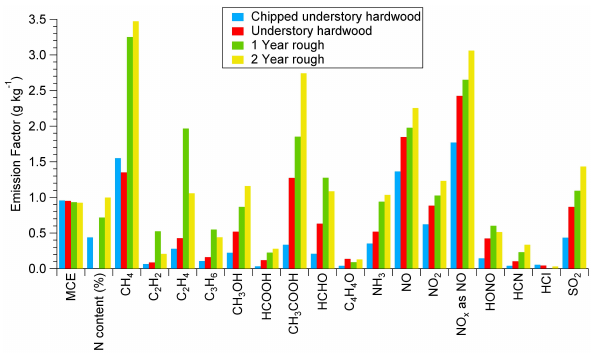
Fig. 11. Emission factors for fuels representing various land man- agement strategies at Camp Lejeune. MCE (unitless) and fuel nitro- gen content (%) are shown on the same scale. The nitrogen content of the understory hardwood sample was not